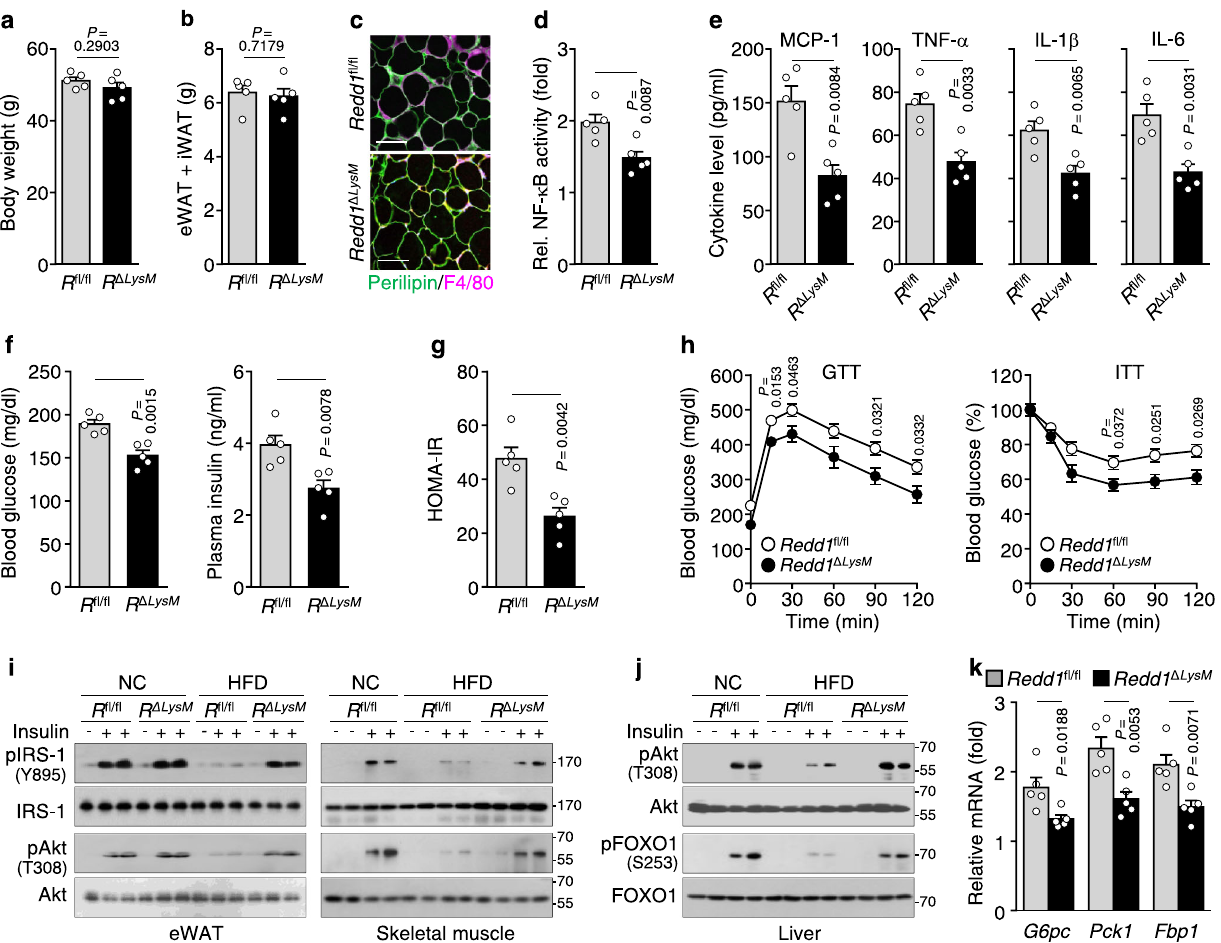
Fig. 4 | Myeloid Redd1 de fi ciency prevents HFD-induced meta-in fl ammation andmetabolicdysregulation.a Weightgainin Redd1 fl / fl ( R fl / fl )and Redd1 Δ LysM ( R Δ LysM ) mice fed HFD for16 weeks( n =5 per group). b Measurement offat(eWAT + iWAT) mass in HFD-fed Redd1 fl / fl and Redd1 Δ LysM mice ( n =5 per group). c Representative images showing perilipin (green) and F4/80 (purple) staining in the eWAT of HFD- fed Redd1 fl / fl and Redd1 Δ LysM mice ( n =5 per group). Scale bar, 100 μ m. d NF- κ B activity in the eWAT from HFD-fed Redd1 fl / fl and Redd1 Δ LysM mice ( n =5 per group). e Plasma levels of in fl ammatory cytokines in HFD-fed Redd1 fl / fl and Redd1 Δ LysM mice ( n =5 pergroup). f Fasting plasma levels ofglucose and insulin in HFD-fed Redd1 fl / fl and Redd1 Δ LysM mice ( n =5 per group). g Calculation of HOMA-IR scores in HFD-fed